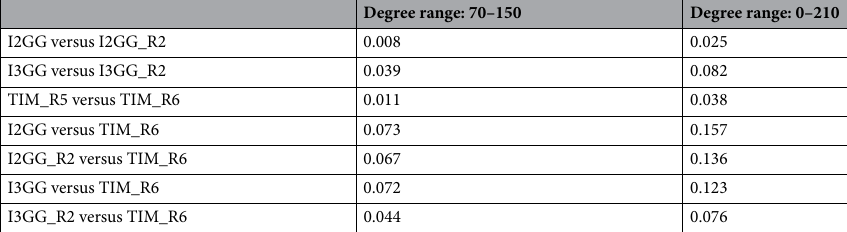
Table 2. RMS values of geoid differences (unit: m) of I2GG versus I2GG_R2, I3GG versus I3GG_R2, TIM_R5 versus TIM_R6, I2GG versus TIM_R6, I2GG_R2 versus TIM_R6, I3GG versus TIM_R6 and I3GG_R2 versus TIM_R6 for the common degree range of the models, i.e. 0–210 and for the medium- frequency range 70–150 . 1 The RMS values are computed from 1 ◦ ◦ grids excluding the polar caps, i.e. latitude range of − ×